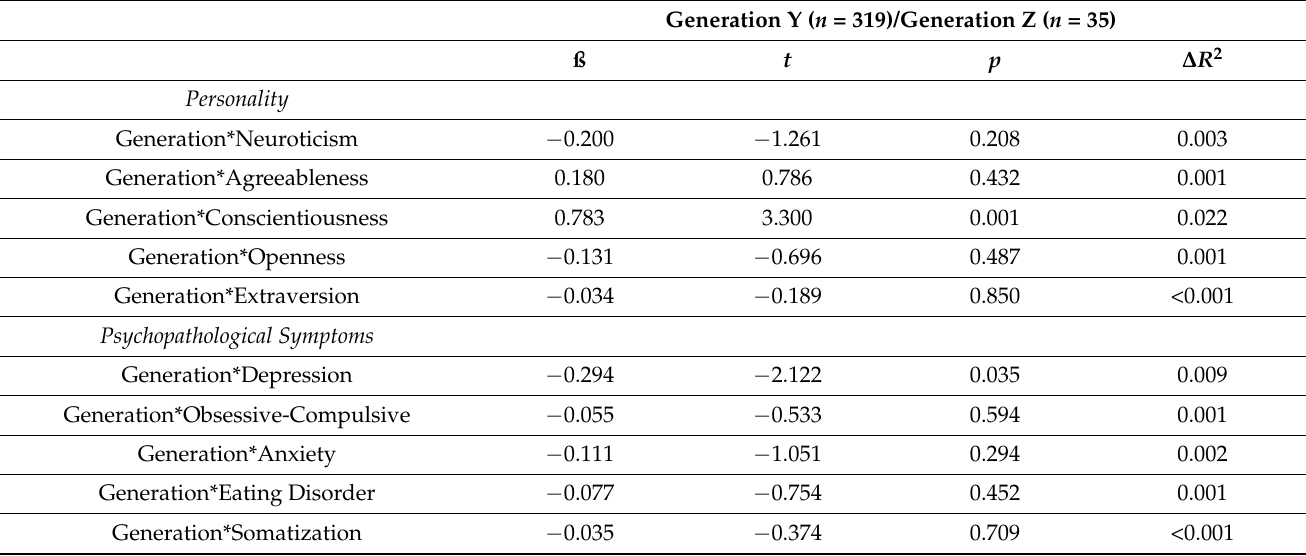
Table 5. Moderation for Generation Y and Generation Z.